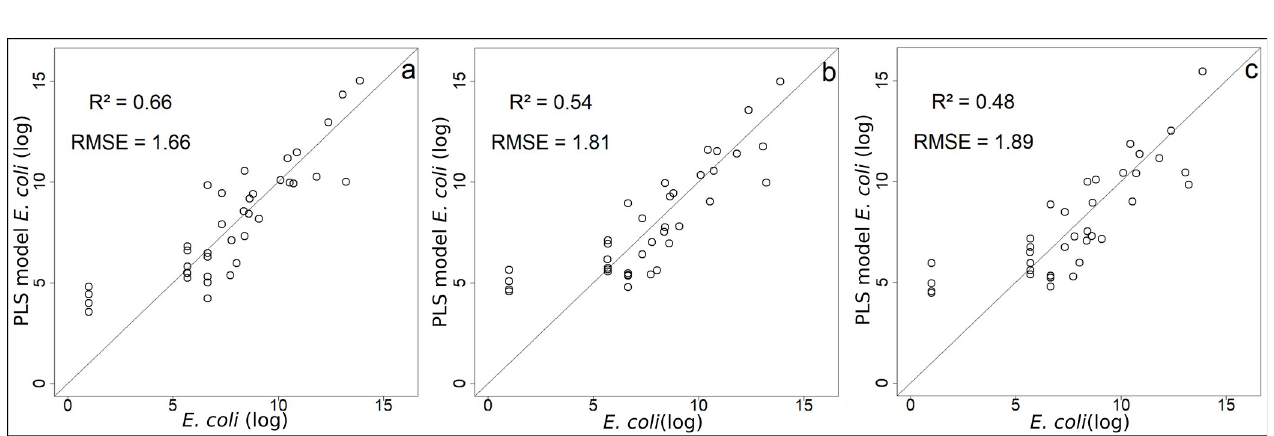
Fig 8. Comparison of models’ predictions with observed E . coli (log values) (a) PLS model with all environmental variables and all components; (b) PLS model with NIR band, SPM and Weekly rainfall and all components; (c) PLS model with satellite variables only (NIR band and Weekly rainfall) and all components.